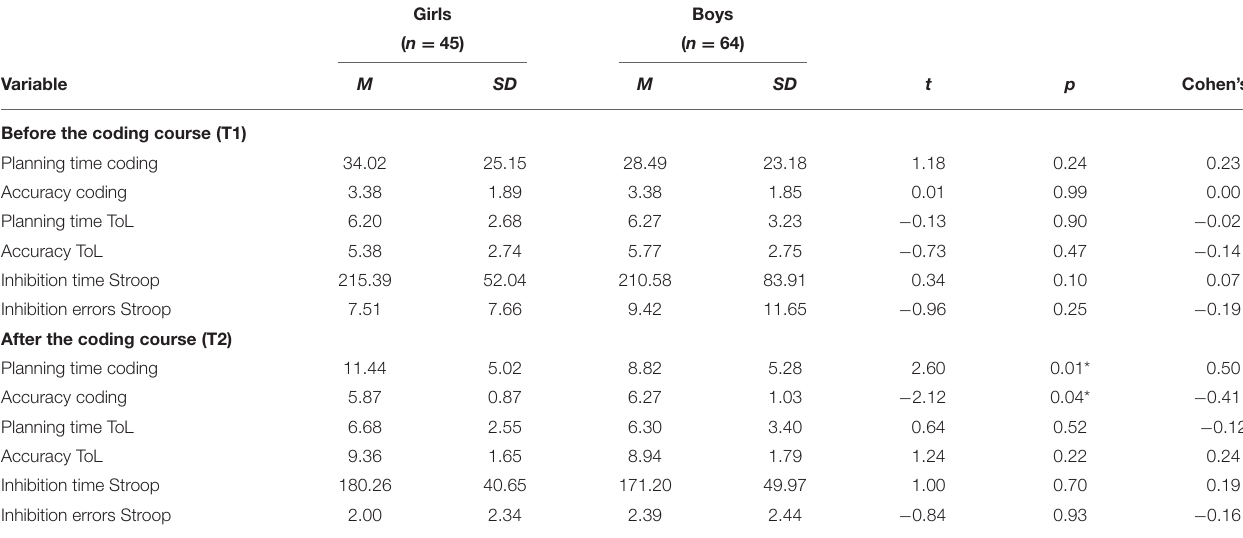
TABLE 3 | Differences between girls and boys in coding, planning, and inhibition skills at time 1 (T1, Before) and Time 2 (T2, After) the coding course.